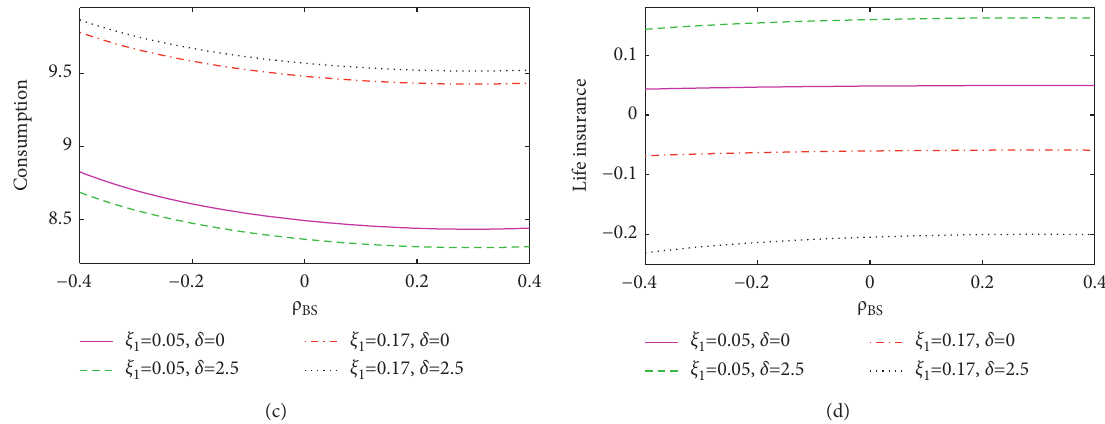
Figure 5: The effects of the correlation between the index bond and stock prices on the optimal strategies.